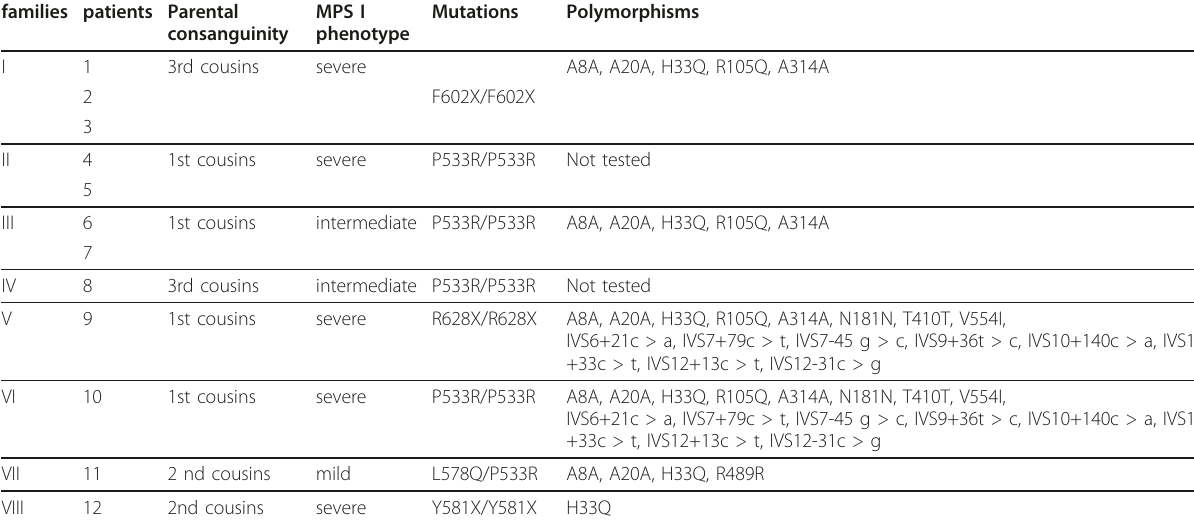
Table 2 Genotypes Characteristics of MPS I Tunisians patients families patients Parental consanguinity